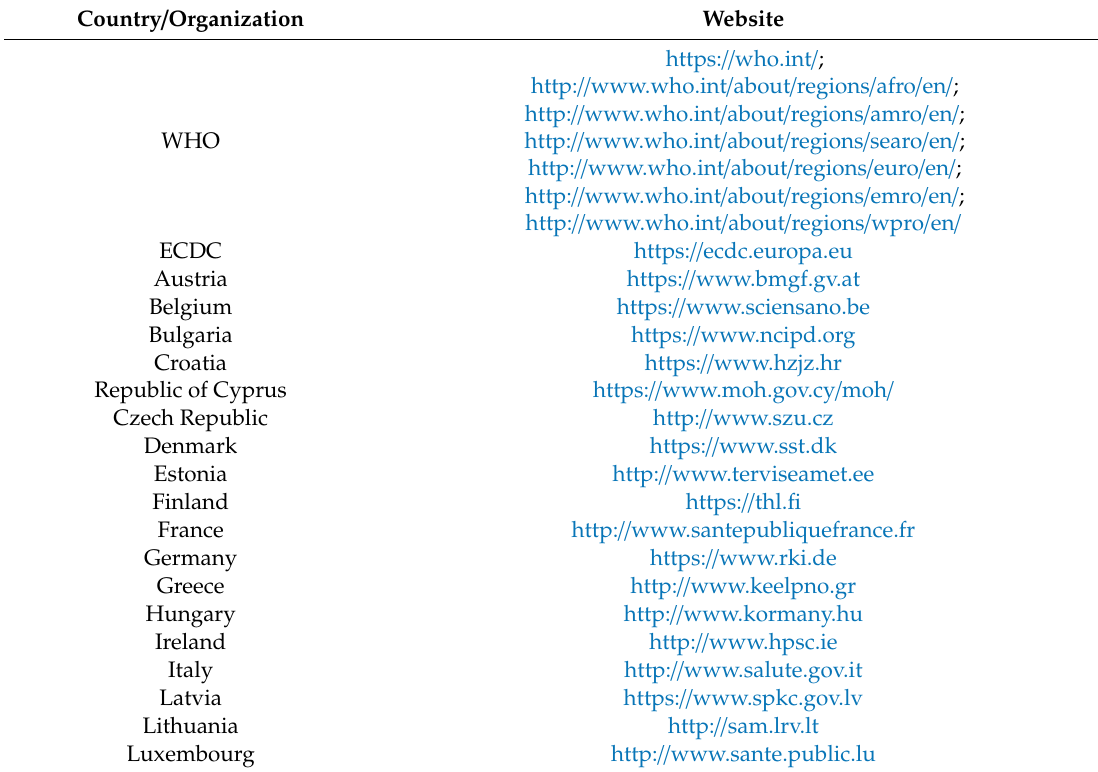
Table A1. List of websites searched as part of the grey